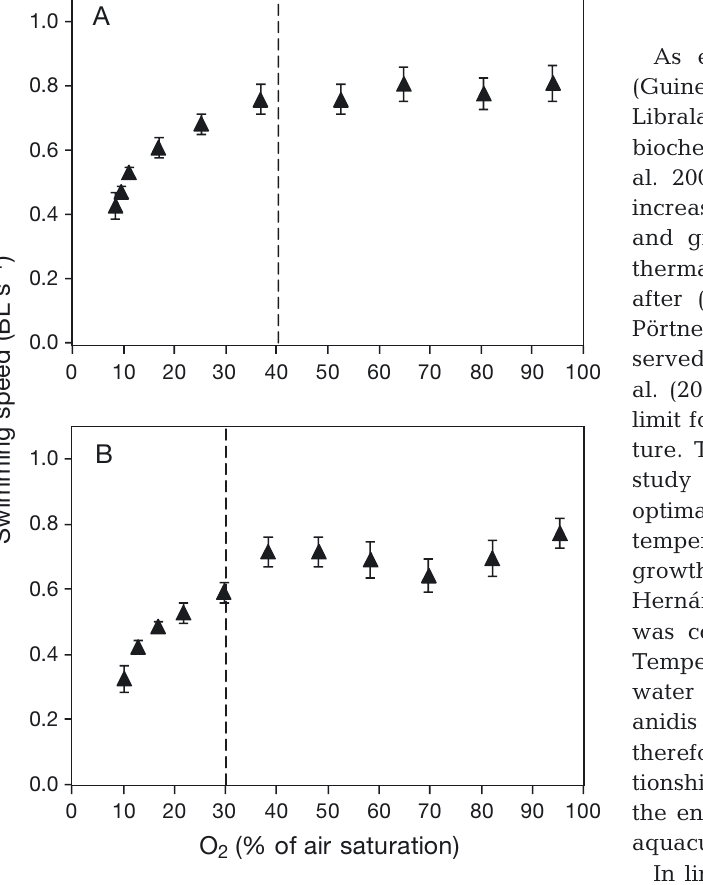
Fig. 3. Mean (± SE, n = 10) swimming speeds (body lengths, BL, s −1 ) of gilthead sea bream Sparus aurata during a pro- gressive decline in O 2 in 2 replicate tanks (A and B) at 20°C. The limiting oxygen saturation levels found for these 2 repli- cate tanks are represented as vertical broken lines. Swimming speed was measured every 10 min during the decline in O